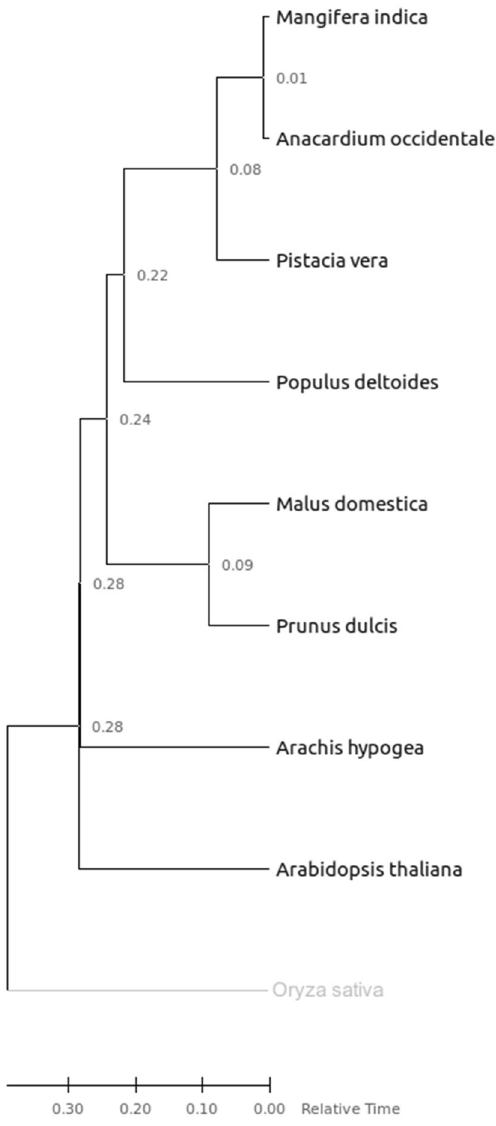
Figure 5. Phylogenetic tree of A. occidentale and nine plant species based on protein sequences of single- copy orthologous genes. The numbers at the nodes of the phylogenetic tree show the relative divergence times between species calculated using the RelTime method. The scale reflects the divergence scale in terms of the number of substitutions per site (amino